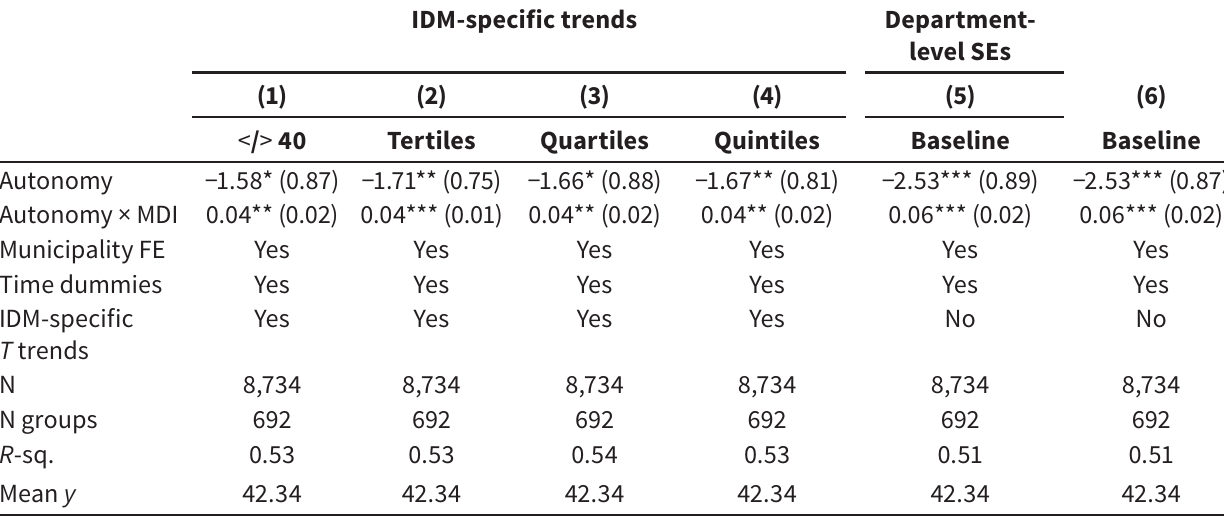
Development-specific time trends: department-level